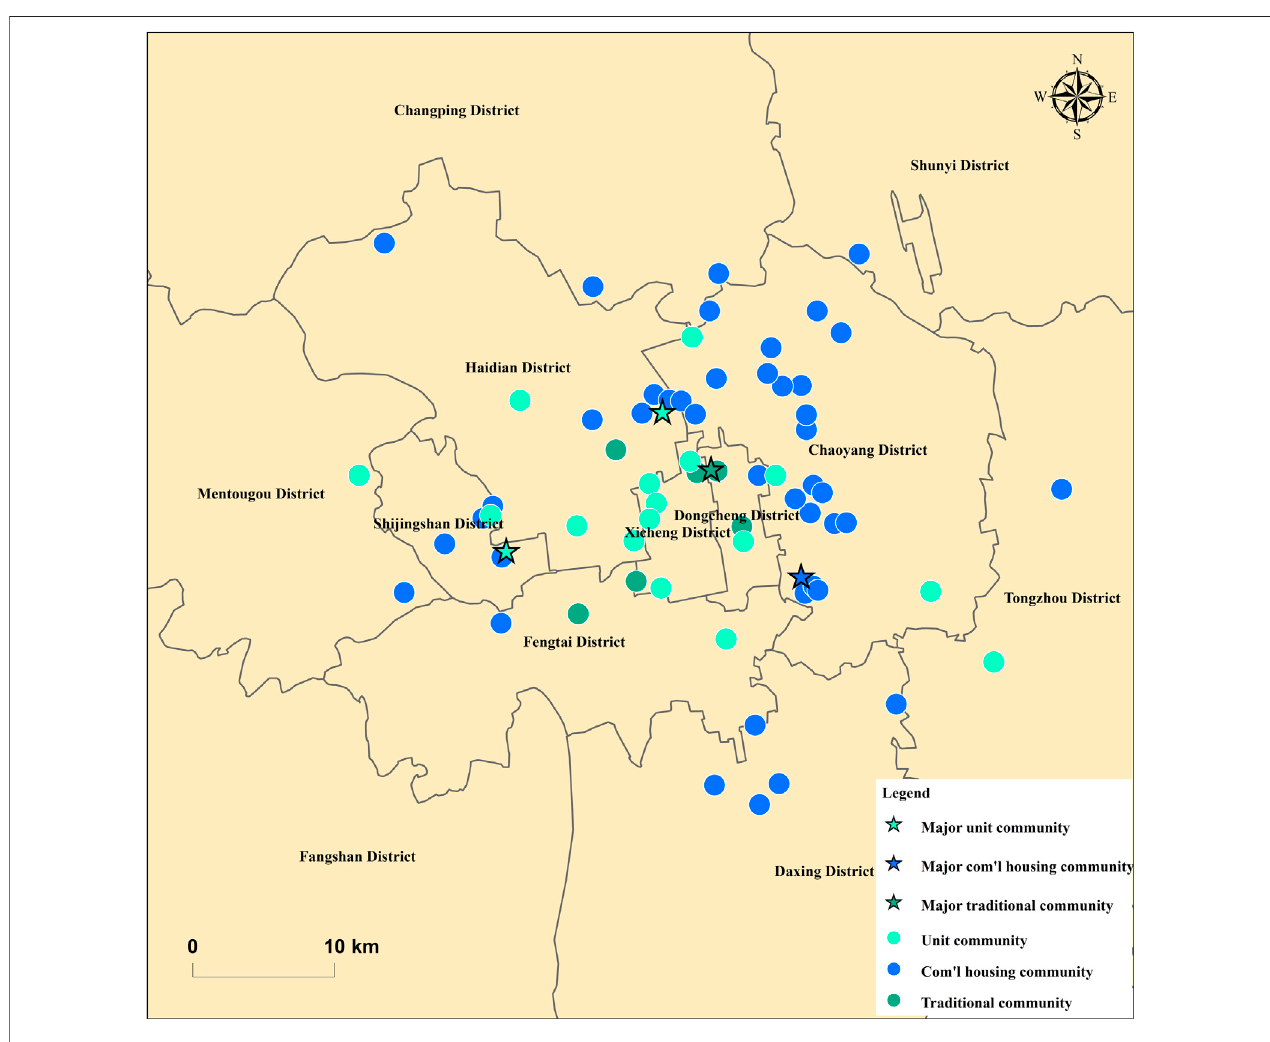
FIGURE 2 | Distribution of the 185 selected household samples.